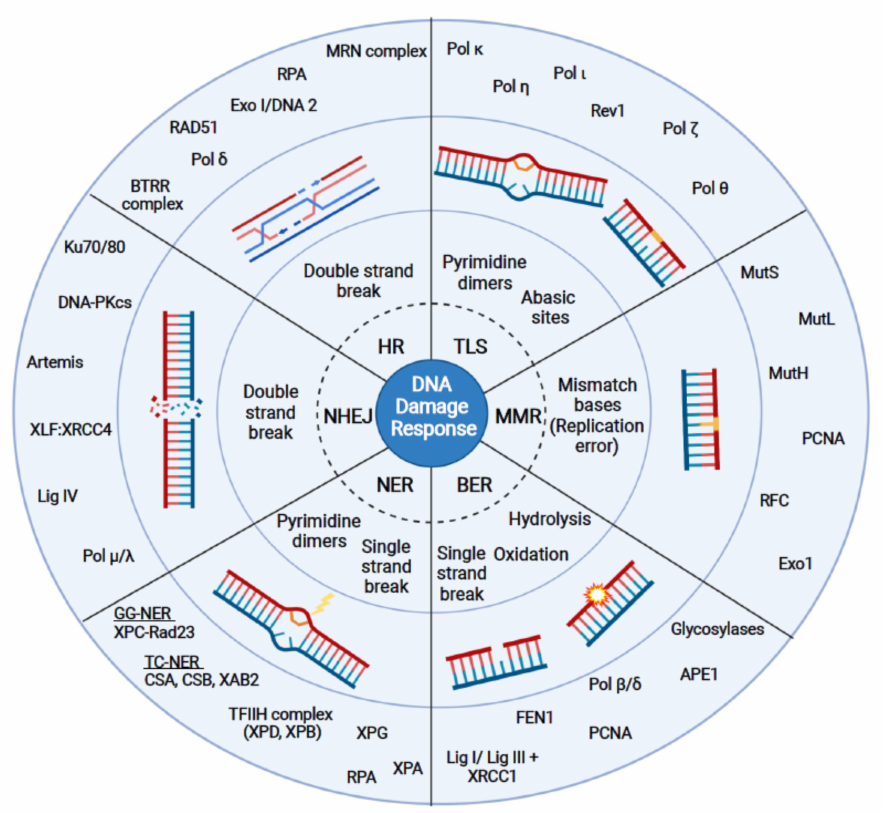
Figure 1. Overview of DNA damage-specific repair pathways. DNA repair mechanisms that are discussed in this review are summarized in this illustration: homologous recombination (HR), non-homologous end joining (NHEJ), base excision repair (BER), nucleotide excision repair (NER), mismatch repair (MMR) and translesion synthesis (TLS). In the inner circle the type of lesion is named and illustrated in the middle circle. In the outer circle major proteins that act during the repair pathway are listed. Figure was created using